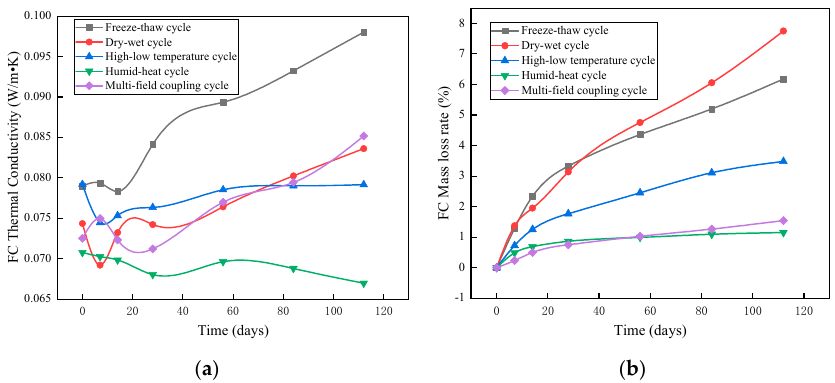
Figure 5. Changes of foam concrete in weathering resistance tests: ( a ) thermal conductivity of foam concrete, and ( b ) mass loss of foam concrete.